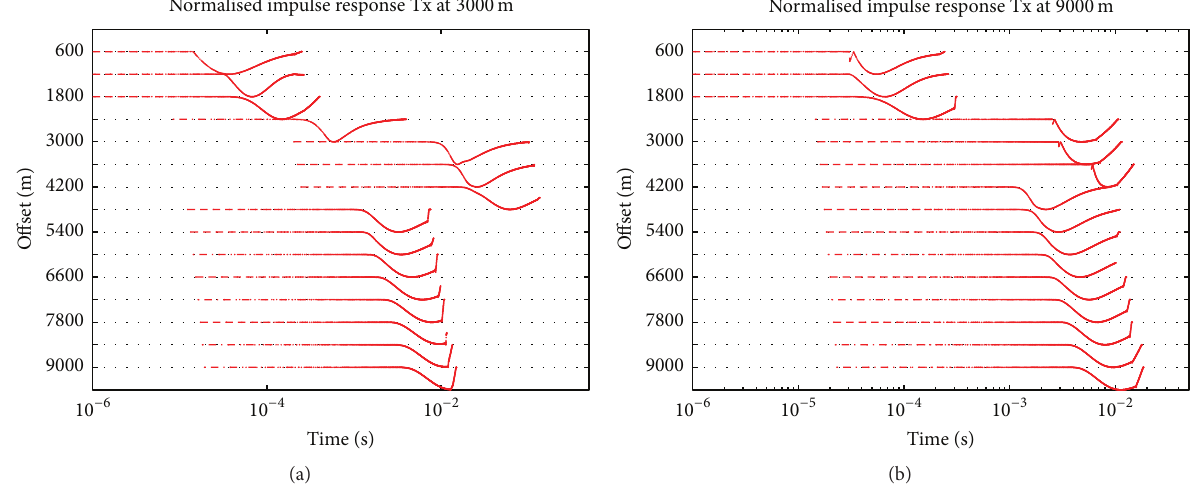
Figure 14: Processed earth impulse response plot at offsets ranging from 600 m to 9000 m at an interval of 600m, with Tx at (a) 3000 m and (b) 9000